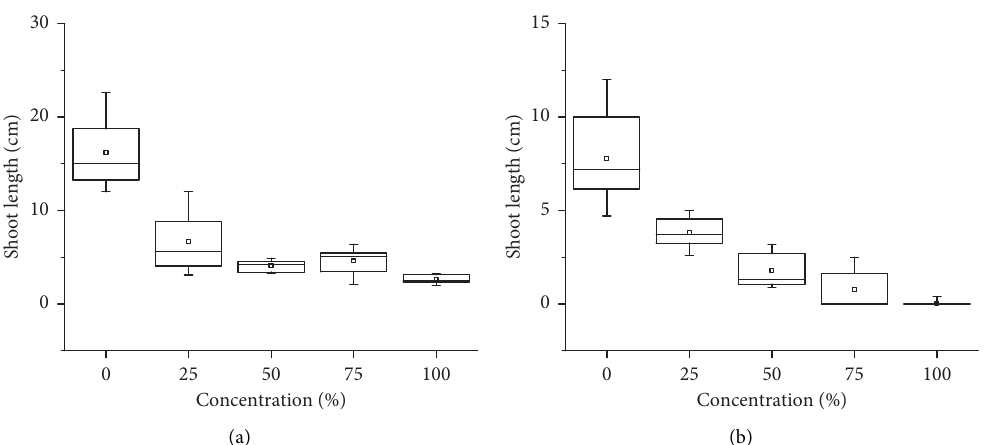
Figure 1: Shoot length of germinated P. vulgaris (a) and O. sativa (b) seedlings in laboratory experiment after 7 and 14 days of treatment with S. suaveolens extracts, respectively.